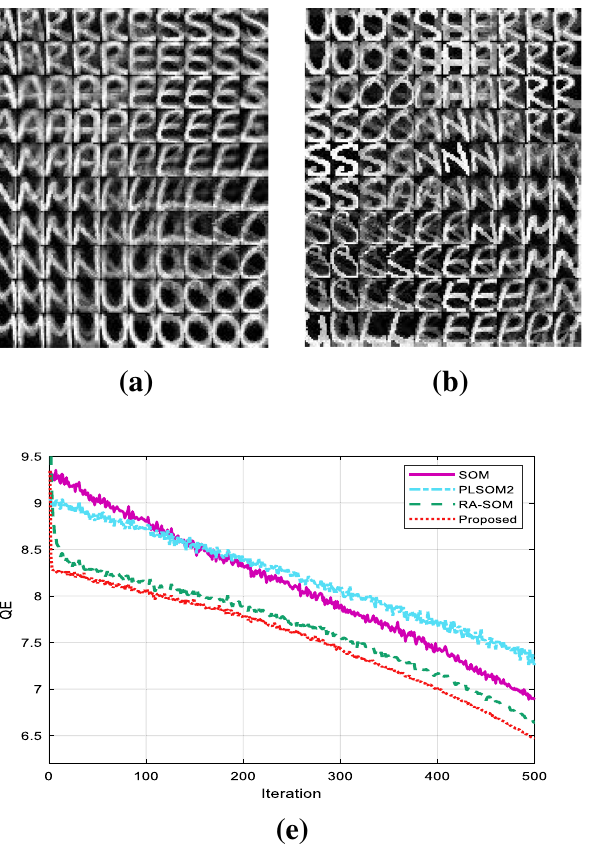
b Neighborhood construction behavior for PLSOM2, c Neighborhood construction behavior for RA-SOM, d Neighborhood construction behavior for proposed VLR-SOM, e QE, and f TE